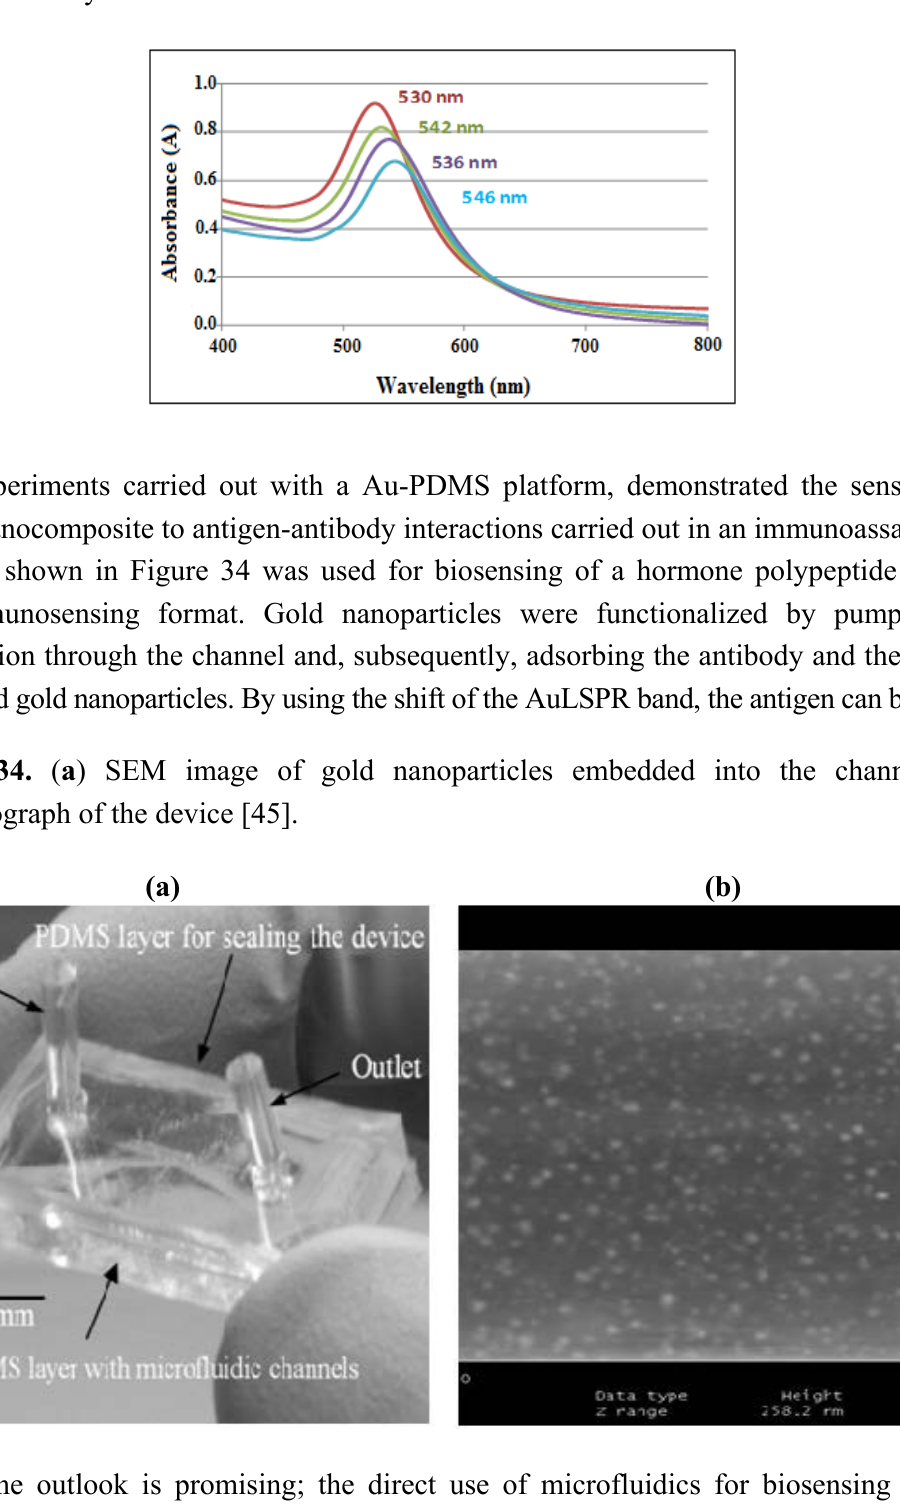
Figure 33. Plasmon band of Au in the nanocomposite corresponding to different stages of the